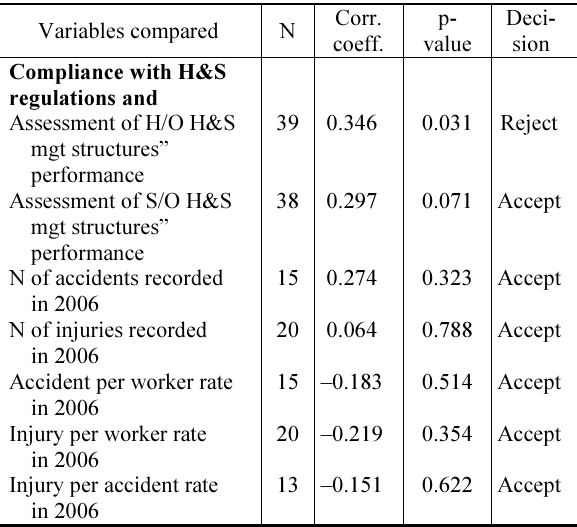
Table 3. Results of Spearman correlation between